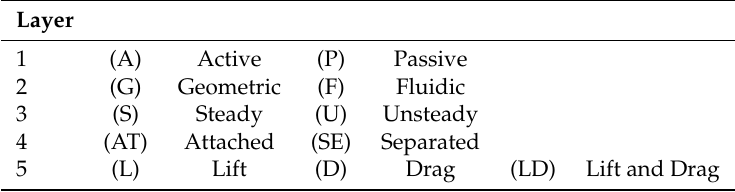
Table 1. Actuator classification used by Wood [7] for actuators in unmanned aerial vehicles.